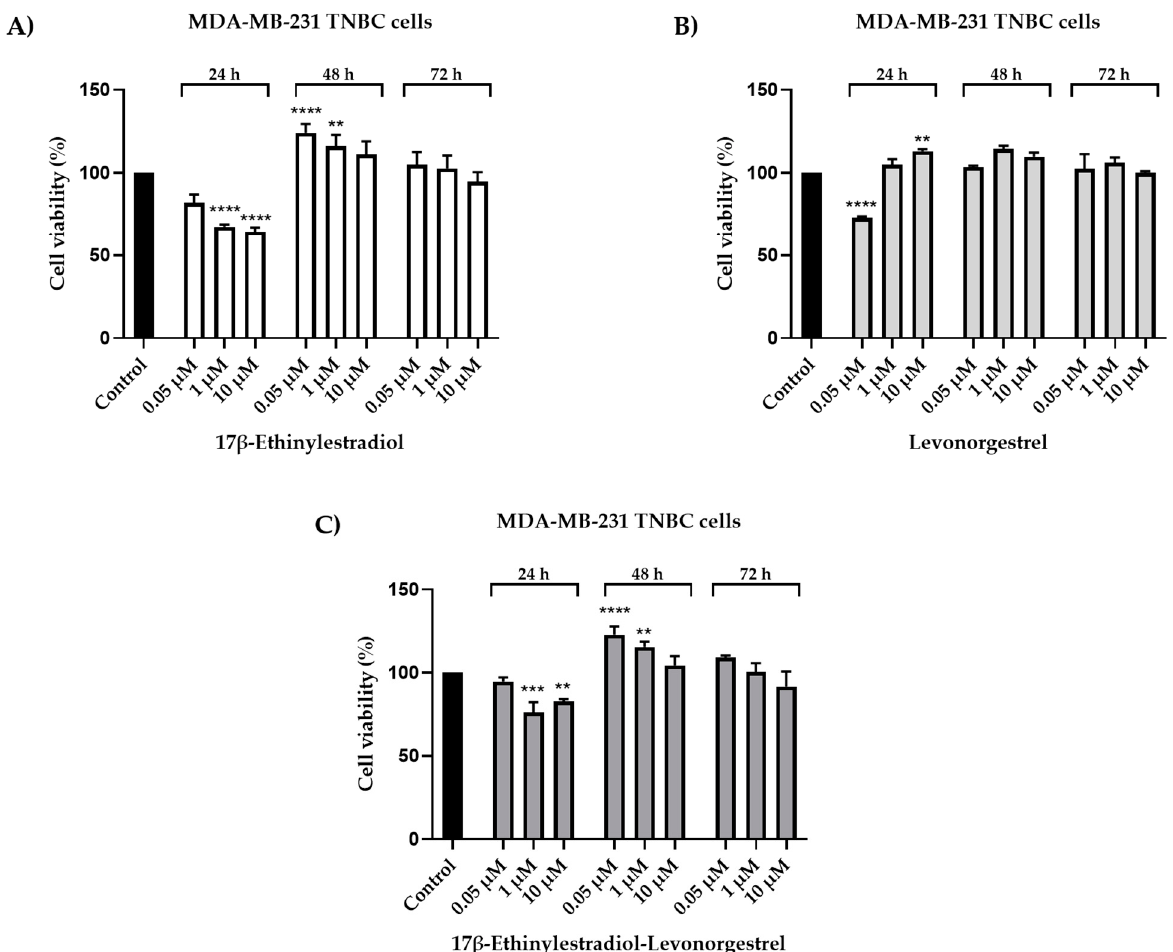
Figure 1. In vitro assessment of: ( A ) 17 β -Ethinylestradiol, ( B ) Levonorgestrel, and ( C ) 17 β -Ethinylestradiol-Levonorgestrel (0.05, 1, and 10 µ M) impact on the viability of MDA-MB-231 triple-negative breast cancer cells after 24, 48, and 72 h of treatment by applying the MTT assay. The data are presented as cell viability percentage (%) normalized to control (untreated) cells and are expressed as mean values ± SD of three independent experiments performed in triplicate. To identify the statistical differences between the control and the treated group, the one-way ANOVA analysis was conducted, followed by the Dunnett’s multiple comparisons post-test (** p < 0.01, *** p < 0.001, and **** p < 0.0001).